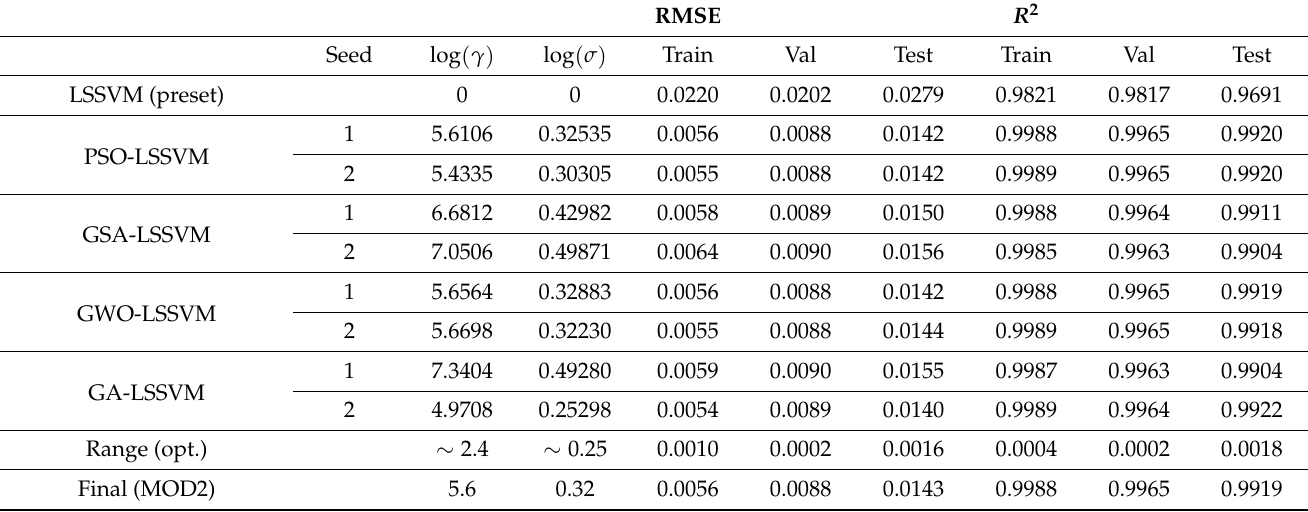
Table 4. Optimized LSSVM metaparameters using different optimizers and different initializations (marked 1 and 2) and corresponding performance metrics on the training, validation and testing datasets. The parameters used in the final model, MOD2, are indicated. RMSE R